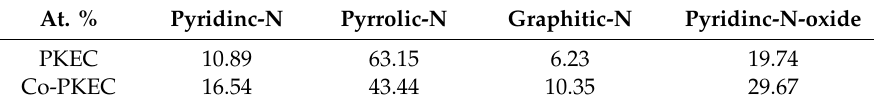
Table 3. Composition of nitrogen elements in PKEC and Co-PKEC.